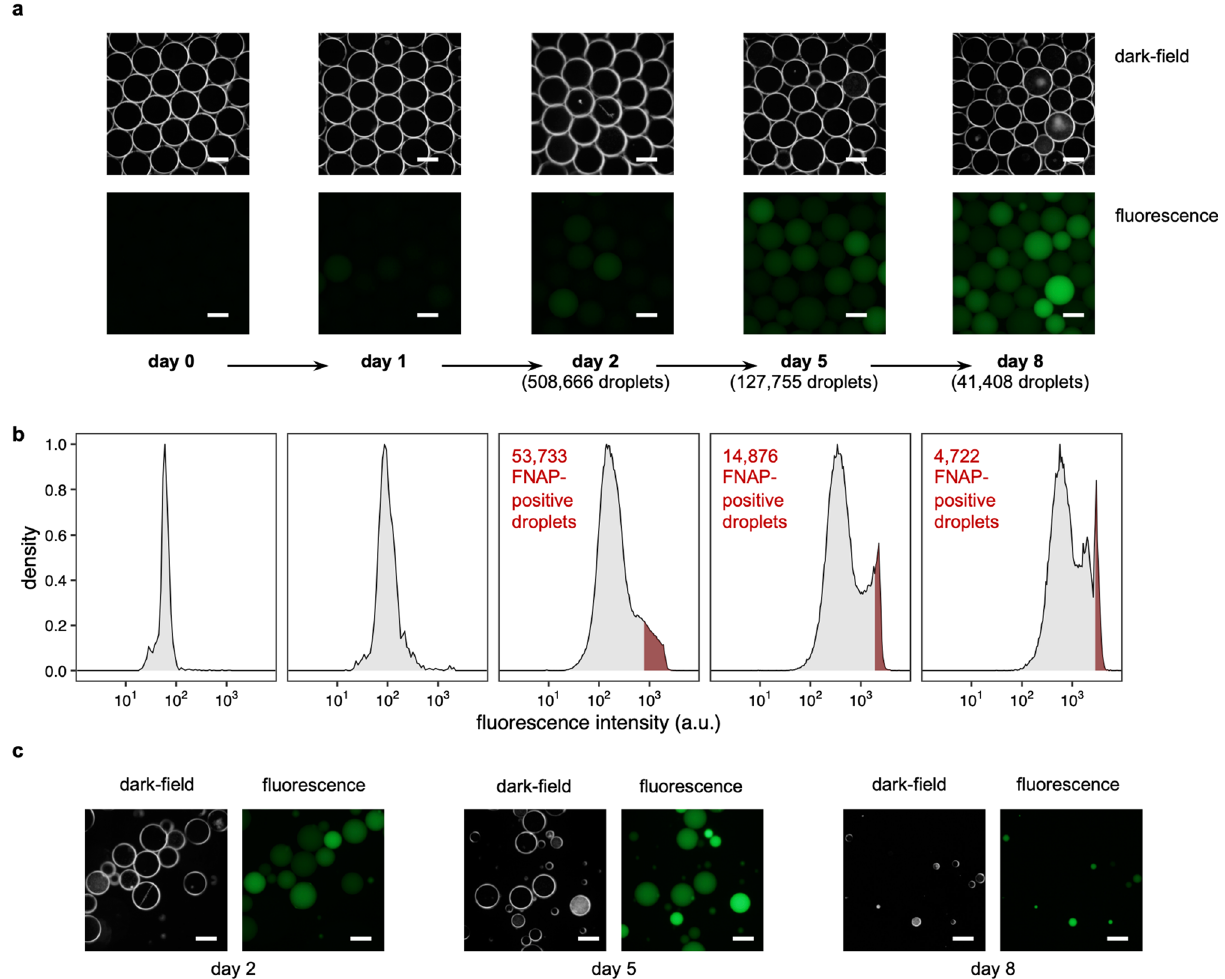
Figure 2. Evaluation of droplet-based cultivation and sorting. ( a ) Dark-field and fluorescence micrographs of generated droplets (day 0) and after different days of incubation (days 1–8). For days 2, 5, and 8, the total number of analyzed droplets is indicated. ( b ) Histograms of droplet fluorescence intensities as measured by on-chip flow cytometry. For days 2, 5 and 8, the red shaded area represents the top-10% brightest droplets, defined as FNAP-positives. ( c ) Dark-field and fluorescence micrographs of FNAP-positive droplets sorted after different days of incubation. The scale bar across all photographs is 100